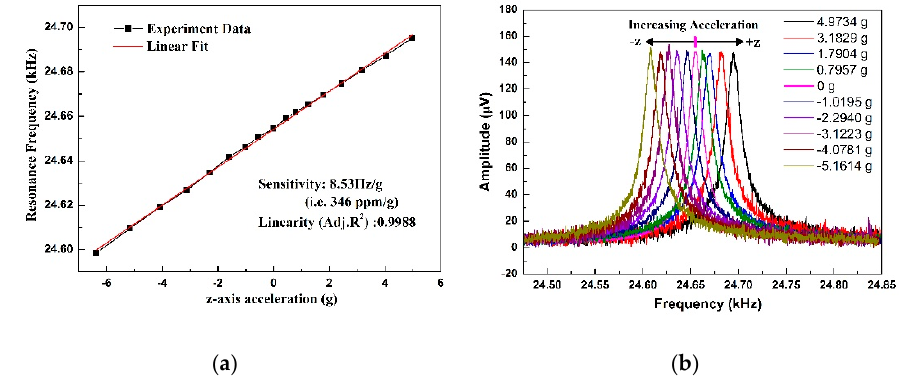
Figure 10. ( a ) Sensitivity of the accelerometer; ( b ) resonant peaks at different accelerations.